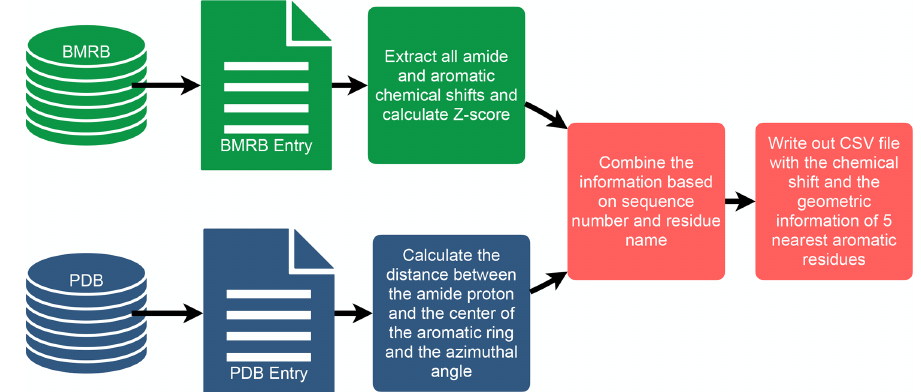
Figure 2. Manual federation of BMRB and PDB via a customized workflow.